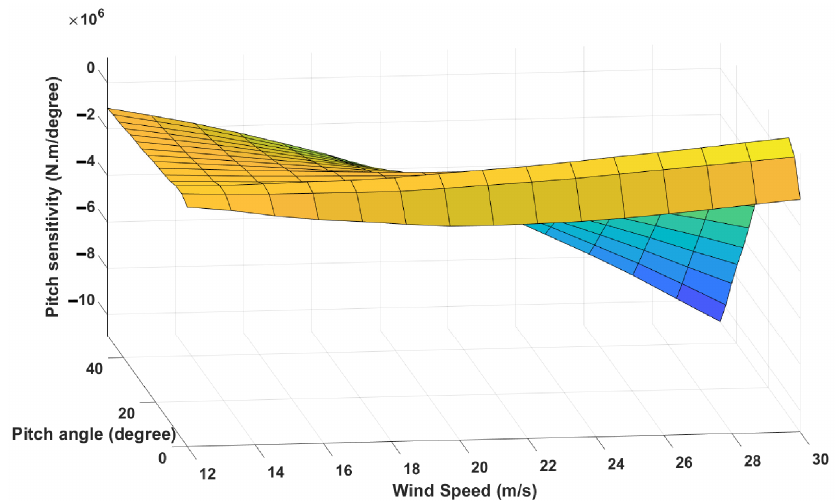
Figure 10. ANFIS surface for the pitch sensitivity as a function of effective wind velocity and pitch angle.